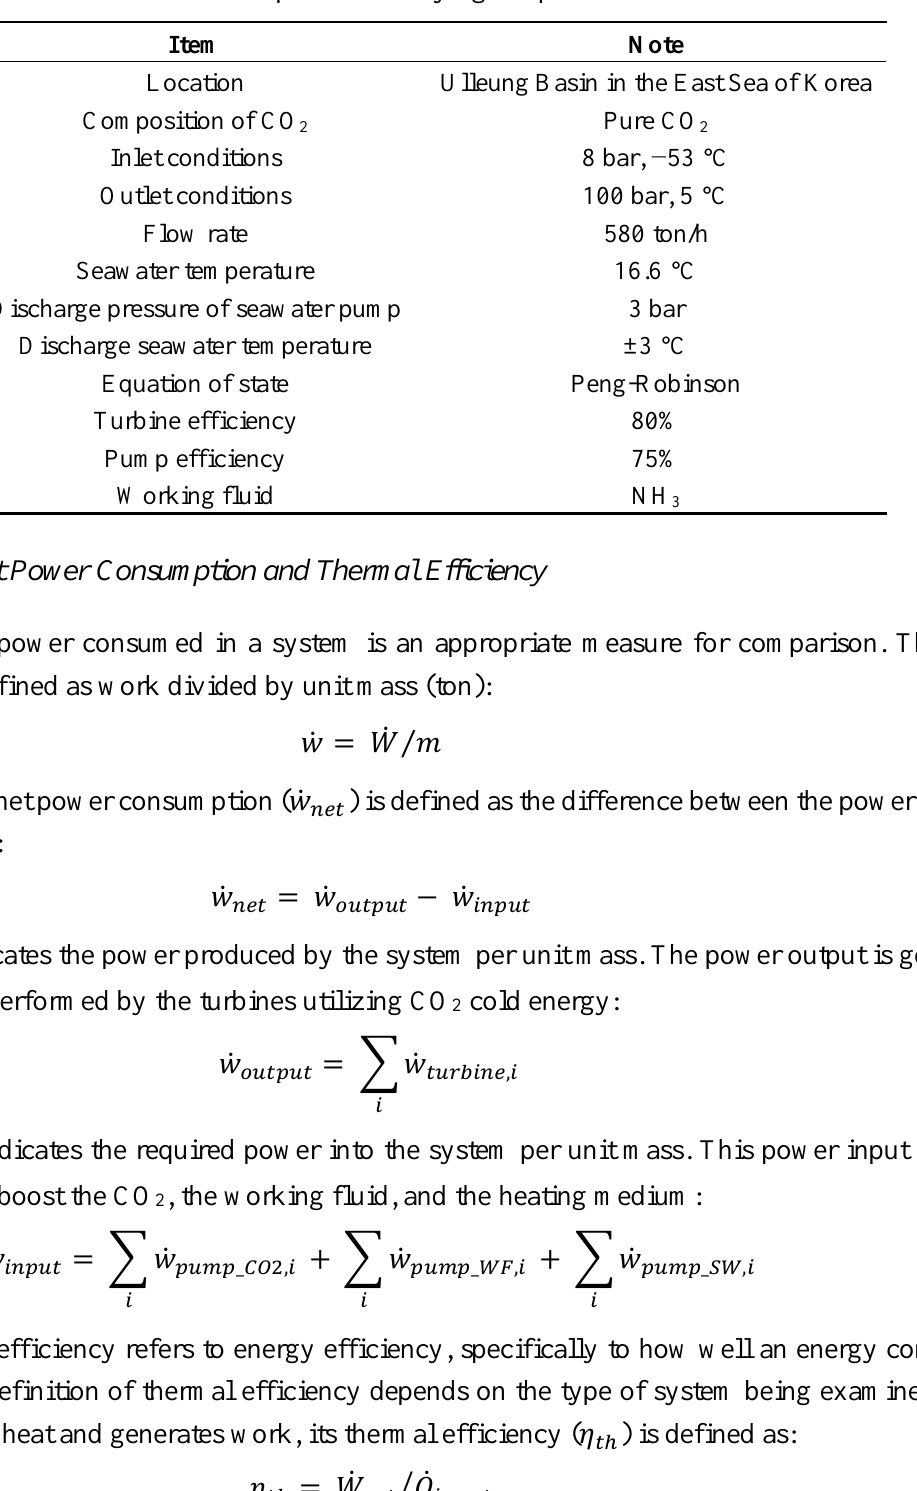
Table 2. Assumptions underlying the process